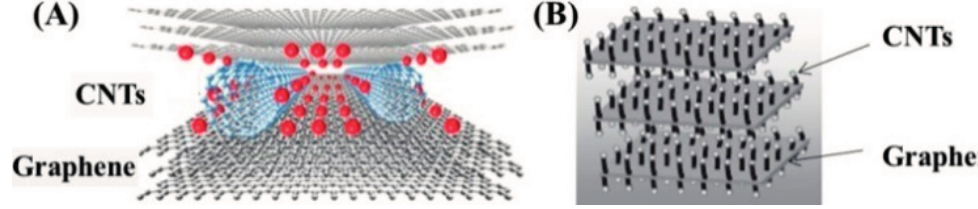
Figure 1. Two models of the 3D CNTs/graphene sandwich structures, where CNTs serve as a spacer to stabilize graphene sheets from agglomeration. Adapted from [97] with permission from the PCCP Owner Societies and from [98] with permission from John Wiley and Sons,